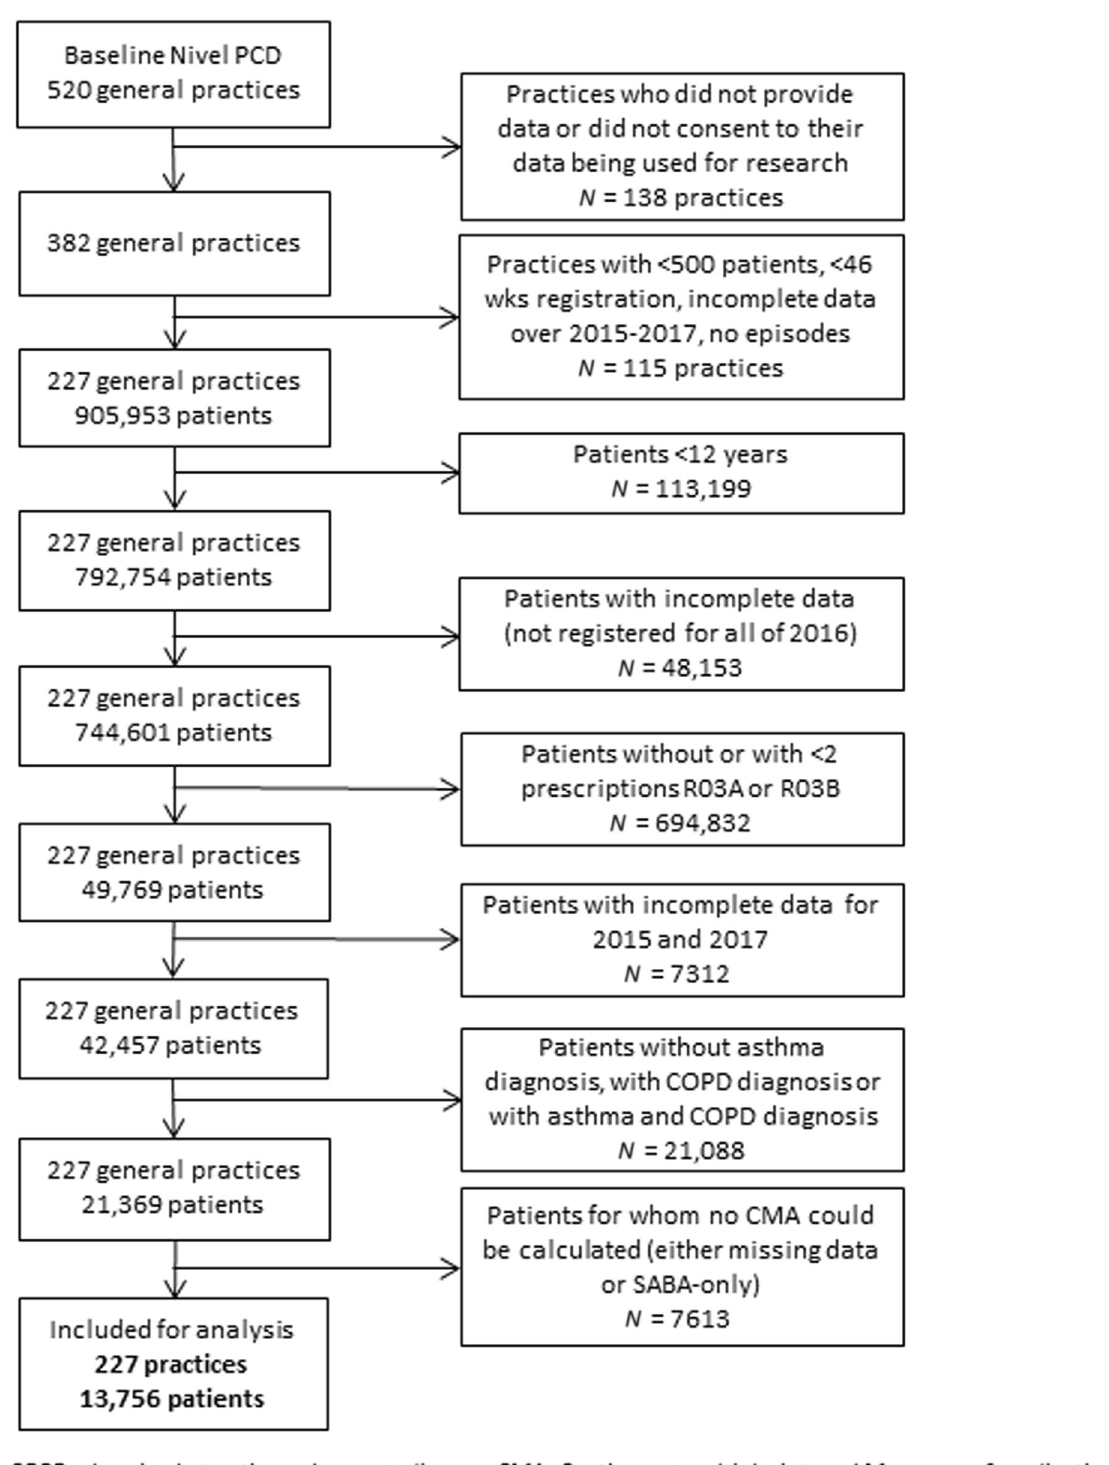
Fig. 2 Flowchart of data preparation and selection